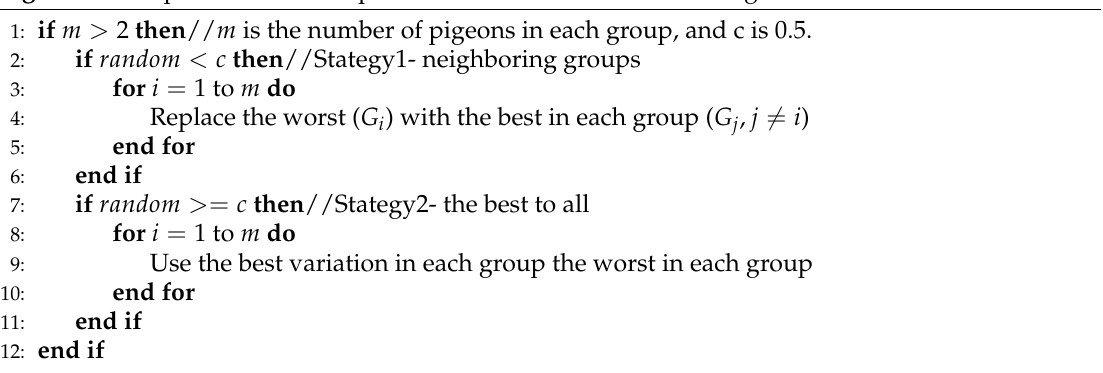
Algorithm 1 A pseudo-code of a parallel with communication